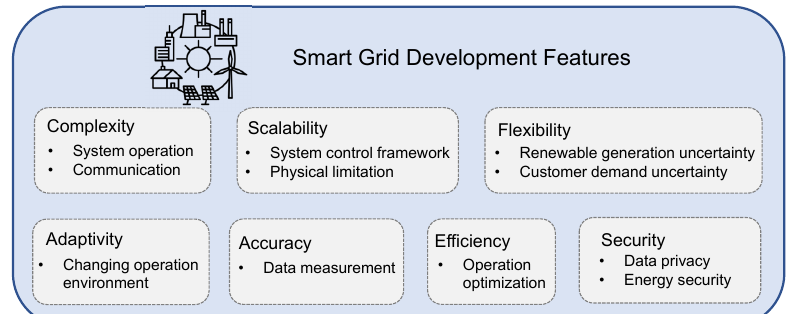
Figure 8. Features of the smart